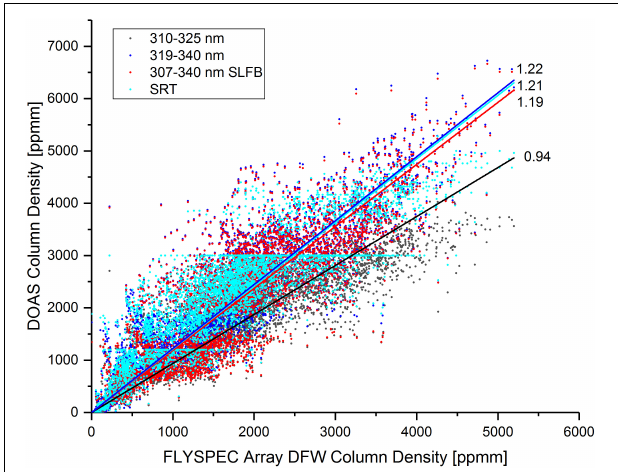
FIGURE 3 | Coincident measurements of FLYSPEC station F0 and co-located stationary upward looking DOAS instrument are analyzed to compare the FLYSPEC DFW spectral analysis method with four different DOAS retrievals. Linear regressions were fit to the results of each method and show systematic differences are relatively small. A conventional DOAS analysis in the 310–325 nm window yields 6% lower values than the FLYSPEC DFW, while the results of the other methods are between 19 and 22% higher than the DFW.